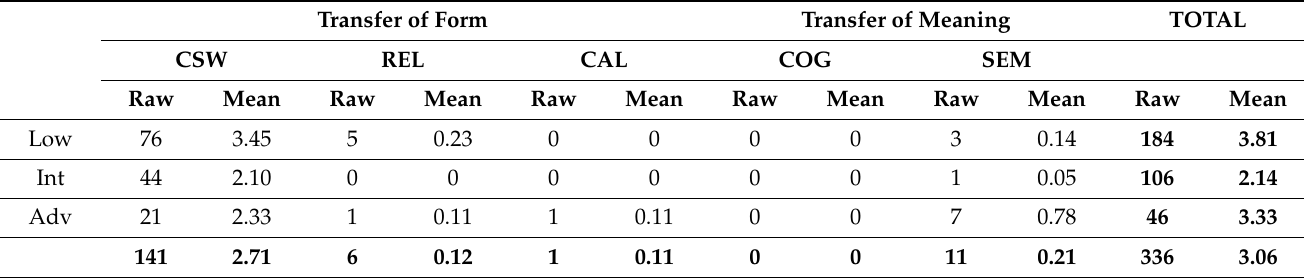
Table 7. Lexical CLI in oral production without interactional